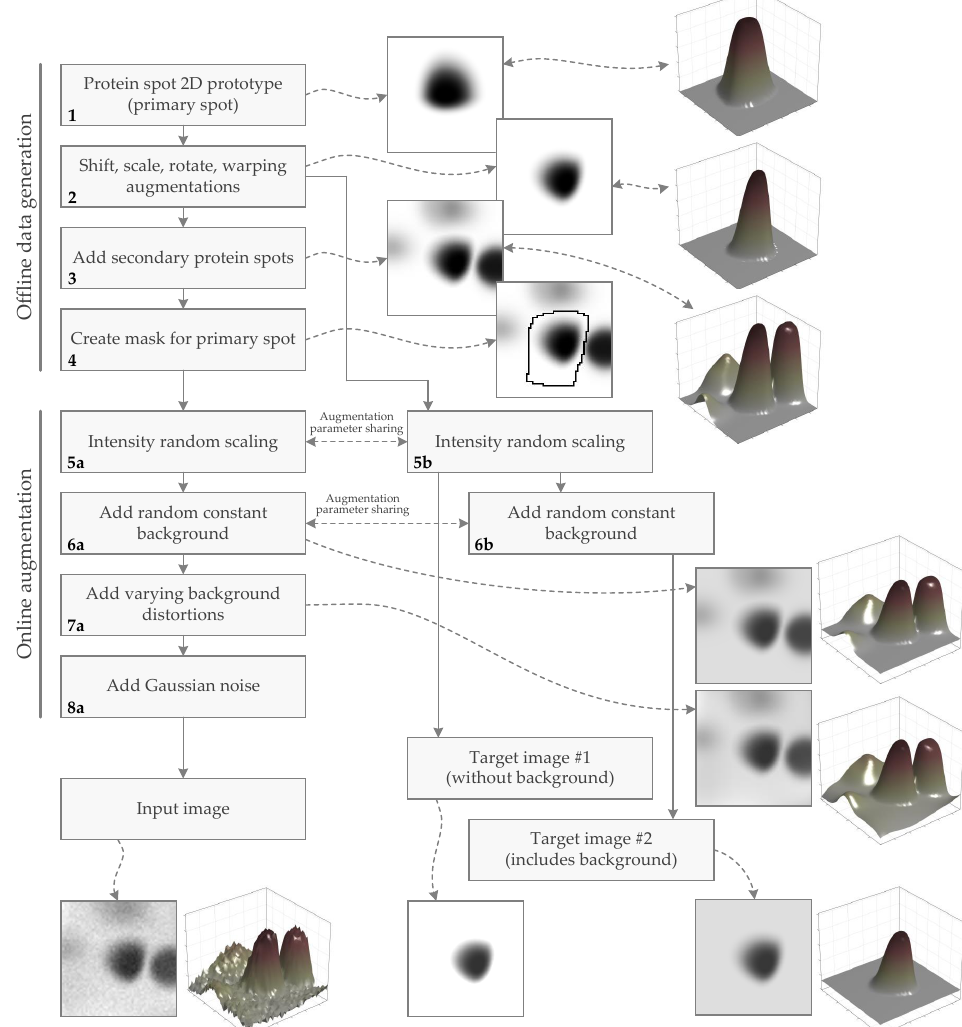
Figure 3. Overview of the generation process of the synthetic protein spot dataset. Outcomes of the workflow steps (image samples) are presented on the side and linked by the curvy dashed lines. The whole data generation workflow may be divided into two basic stages: offline data generation and online data augmentation. The offline stage is more computationally demanding and is performed before training the neural network (NN)-based protein spot model. The online augmentation step is performed during the training process. The whole workflow provides training samples consisting of image pairs: an image corrupted by various noise input and a clean target image. The target images may be of two types, depending on NN’s defined task: with background (if NN must learn to reconstruct spots with the background retained) or without background (if NN must learn to reconstruct spots without the